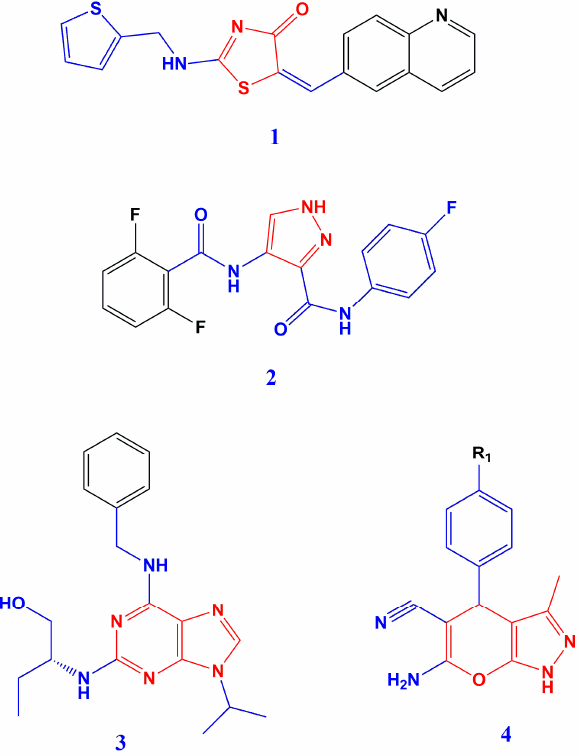
Figure 1. Structural evolution of newer CDK1 inhibitors. thiazolone ( 1 ), pyrazole ( 2 ), purine ( 3 ) and pyranopyrazole ( 4 ) based heterocycles were used to anchor at the CDK enzyme catalytic pocket.